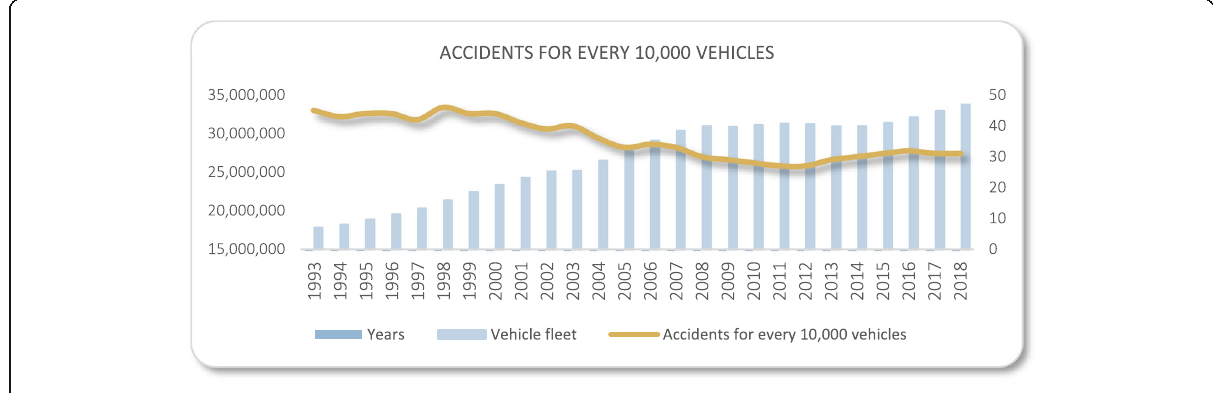
Fig. 15 The accident number in Spain per 10,000